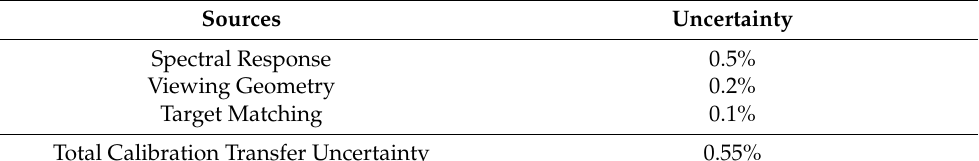
Table 2. Sources of cross-calibration uncertainty in the transfer